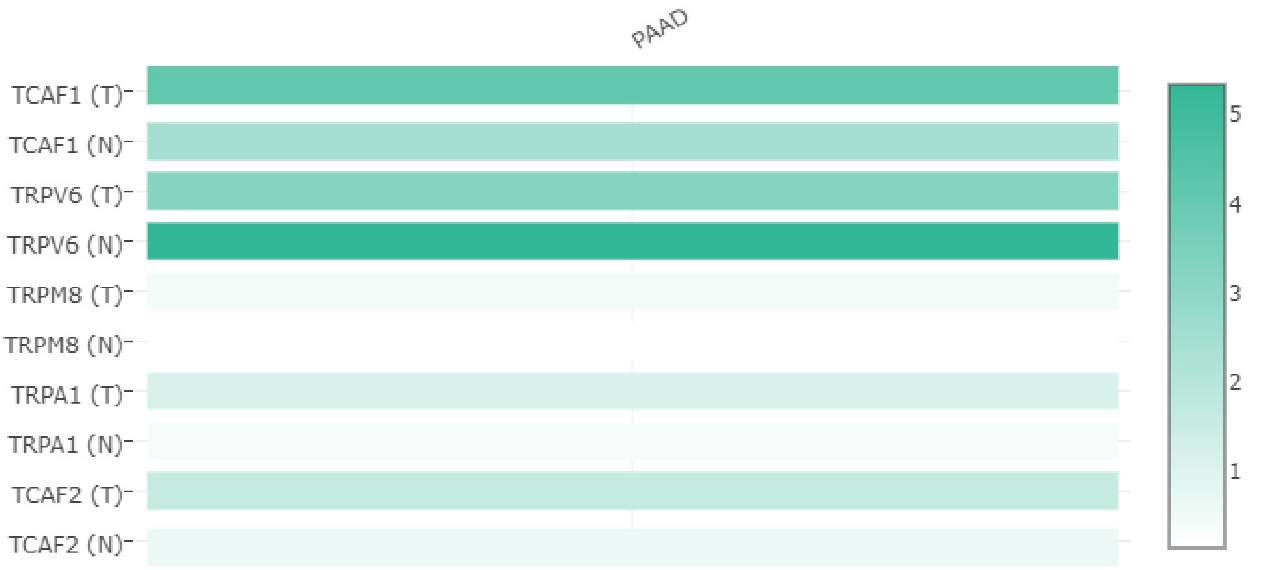
Figure 1. Differential mRNA expression levels of, TRPV6, TRPA1, TRPM8, TCAF1, and TCAF2 in PDAC patients from public datasets. ( A ). mRNA expression levels for PDAC patients analyzed with GEPIA (red for tumor (n = 179), black for normal (n = 171)) ( B ). mRNA expression levels for PDAC patients analyzed with XENA (red for tumor, black for normal). The first and third quartiles are represented by the upper and lower horizontal lines of the box, the median by the center horizontal line, and the maximum and minimum values by the whiskers. * p < 0.05, **** p < 0.0001.